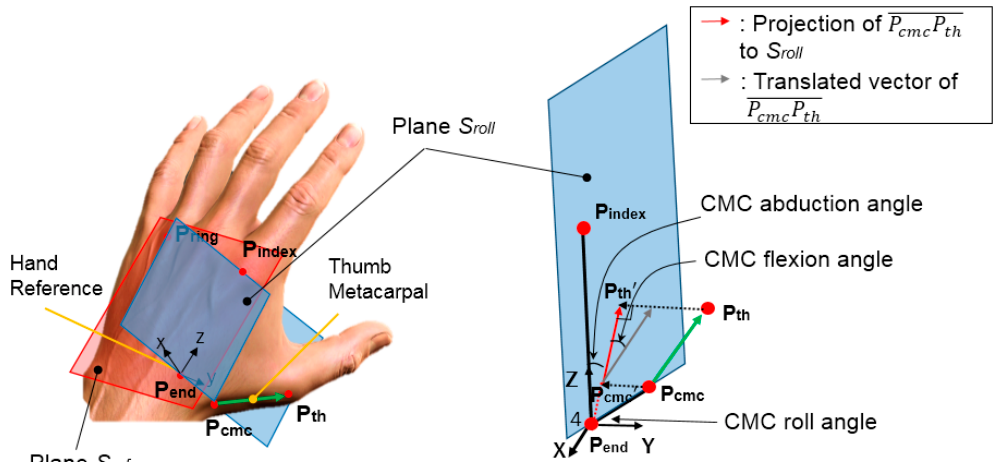
Figure 2. Kinematic definition of CMC-joint angles.